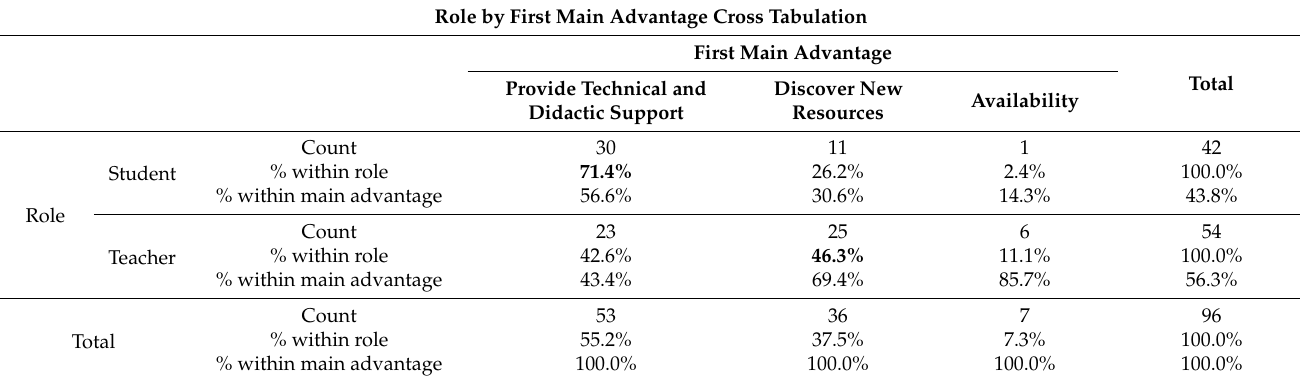
Table 6. Cross tabulation for variables role and first main advantage (with percentages by row and column) Role by First Main Advantage Cross Tabulation